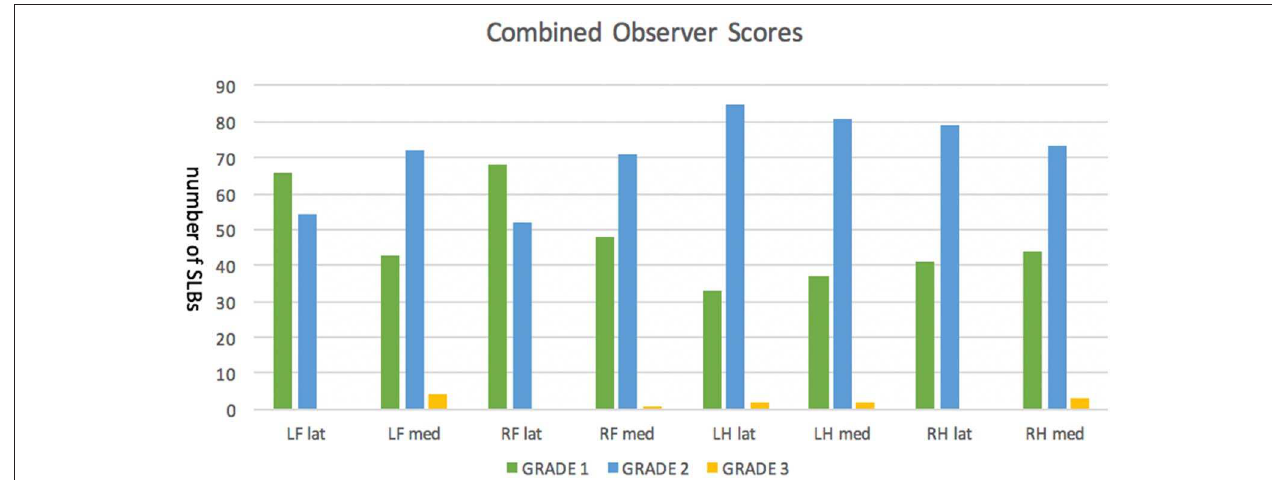
FIGURE 2 | Suspensory ligament branches (SLB) in a population of 60 elite level showjumpers including forelimb (FL) and hindlimb (HL), and medial (med) and lateral (lat) branches were evaluated ultrasonographically, and eight images were stored for each branch. This figure shows the combined SLB scores of two blinded observers using a 0–3 ordinal scale. There were no SLBs with an overall branch score of 0.